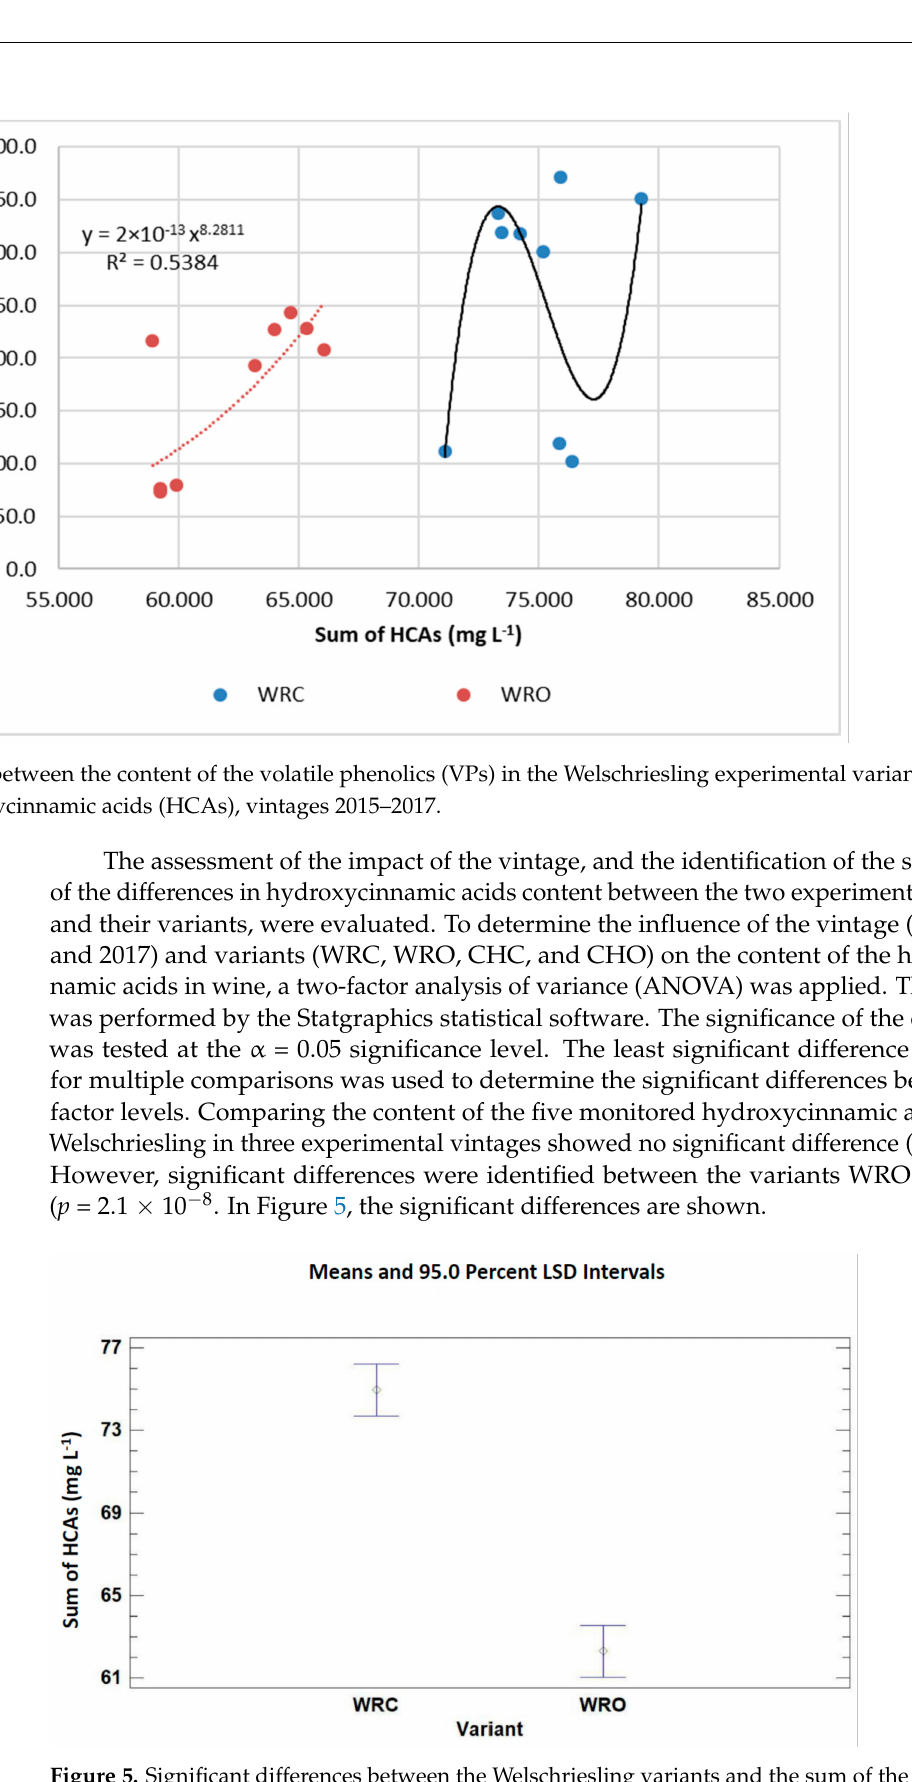
Figure 5. Significant differences between the Welschriesling variants and the sum of the hydroxycin- namic acids